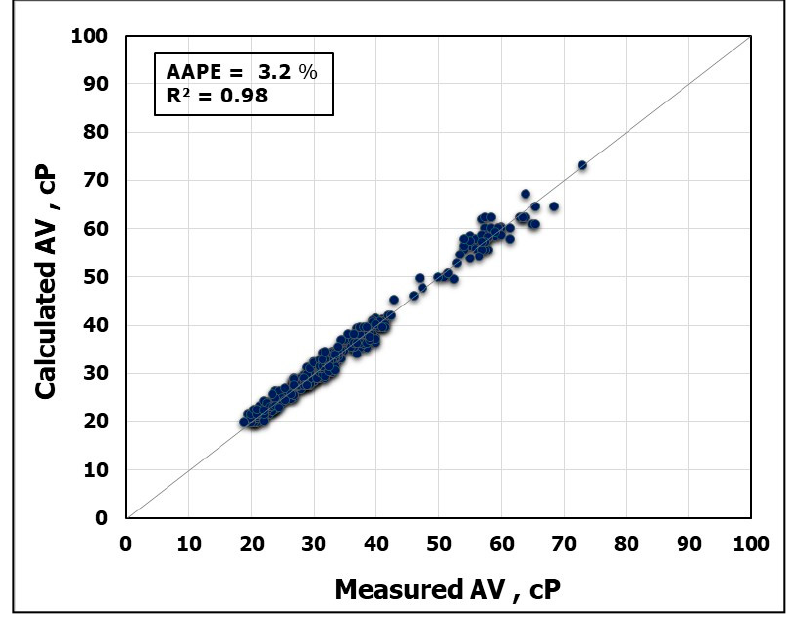
Figure 9. Prediction of 𝐴𝑉 using the developed ANN model ( AAPE of 3.2%).